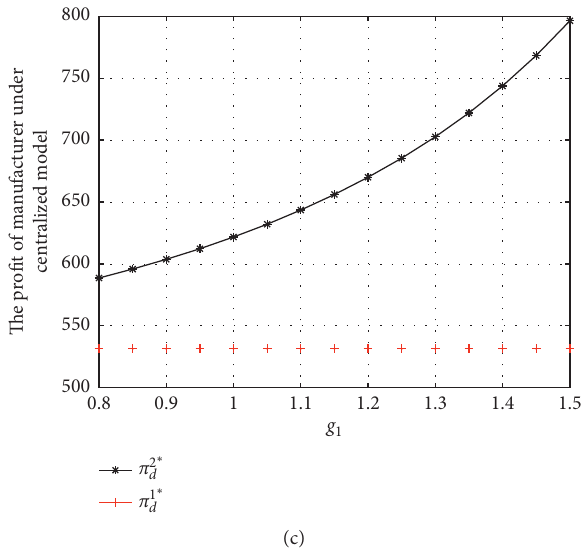
Figure 10: The effect of the value of g